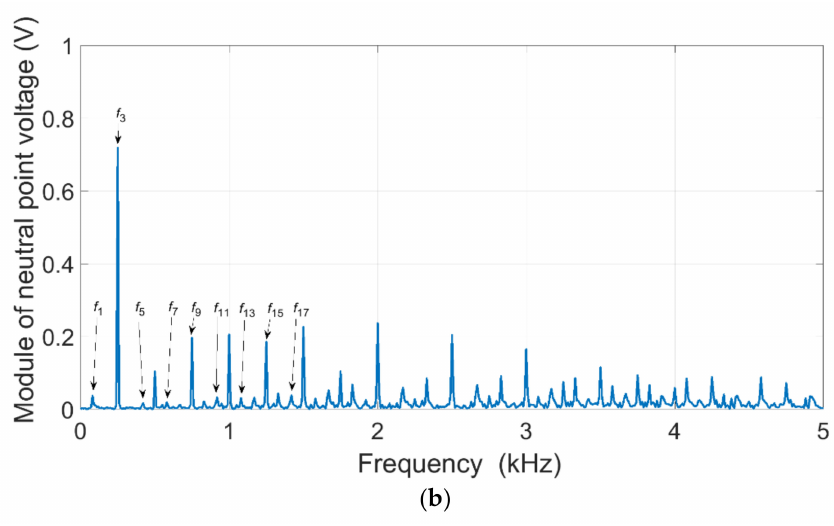
Figure 11. (cid:52) configuration—FFT of neutral voltage—healthy: ( a ) numerical calculations, ( b ) measurement.